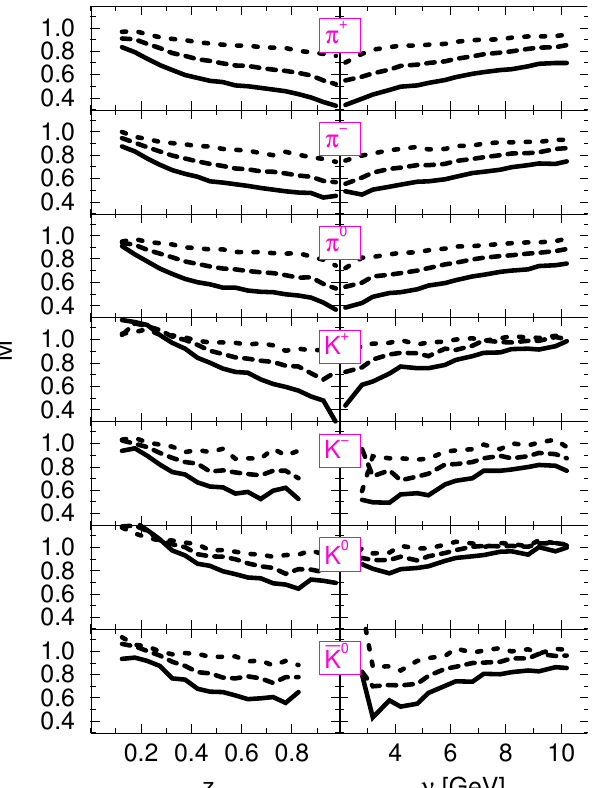
Figure 4. Predicted nuclear modification factors for pions and kaons at 12 GeV at Jefferson Laboratory (JLAB). The short-dashed lines provide results for 12 C, the long-dashed line for 56 Fe and the solid line for 208 Pb. Taken from